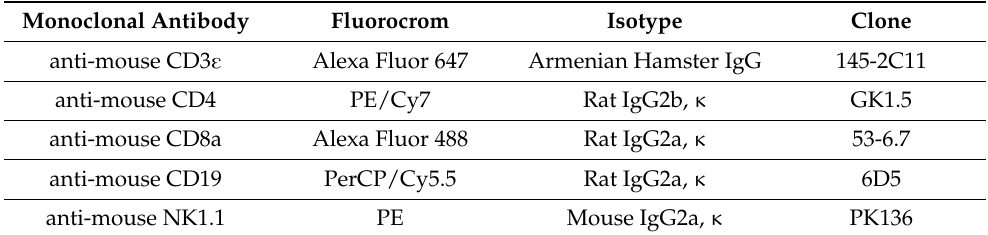
Table 1. Monoclonal antibodies used for lymphocyte immunophenotyping. Monoclonal Antibody